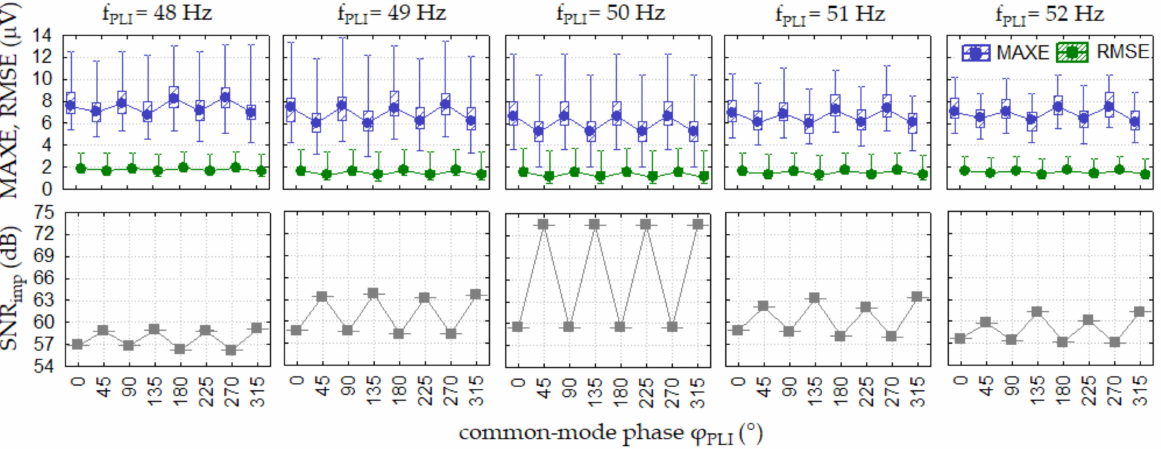
Figure 12. SF algorithm performance for PLI constant (common-mode phase test), computed for 10 s with the PTB Diagnostic ECG database (lead II) and added PLI sinusoid with settings according to Table 2 (Test 3). The boxplots present MAXE, RMSE, and SNR imp statistical distributions (median; box: 25–75%; whisker: